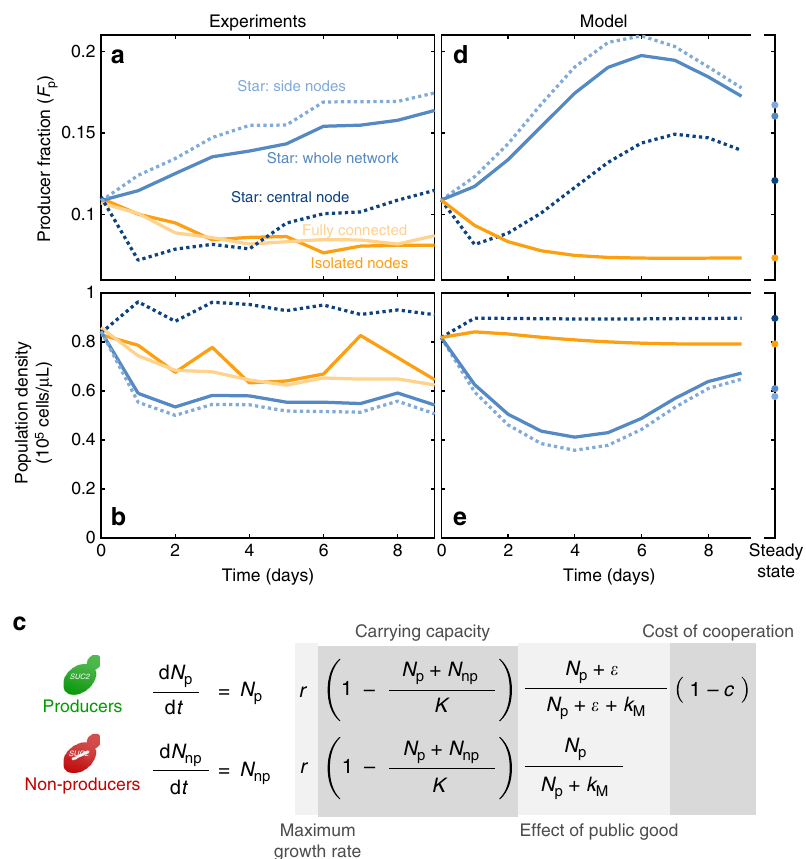
Fig. 2 The increase in producer fraction in all nodes of a star network is captured by a simple phenomenological model. a Experimental results showing the time evolution of the fraction of producers in one star network on average (solid blue line), each type of node within the star network (dashed dark blue line for central nodes and dashed light blue line for side nodes), an isolated population (orange), and the fully connected network on average (pale yellow). b Same as a , but for the total density of cells. c Equations the phenomenological model. N p , N np are the densities of producers and non-producers, respectively (in cells/ μ L); r is the maximum growth rate; K is the carrying capacity (common for both strains); ε corresponds to the amount of enzyme imported by producers before the rest diffuses away (expressed in units of equivalent producer cells/ μ L, see Methods); k M is the amount of producers needed to produce enough enzyme to bring the growth of non-producers to half its maxiumum value; c is the cost of producing the public good. Model parameters: r = 0.5 h -1 , K = 90,000 cells/ μ L, c = 0.07, ε = 14 cells/ μ L, k M = 26 cells/ μ L, growth cycle 22 h, dilution factor 650 and migration rate m = 0.6 per cycle (~0.06 per generation). d Same as a , but as predicted by the model (points show the steady state after 100 cycles). Results for isolated nodes and fully connected networks overlap exactly. e Same as b , but as predicted by the model. Results for isolated nodes and fully connected networks